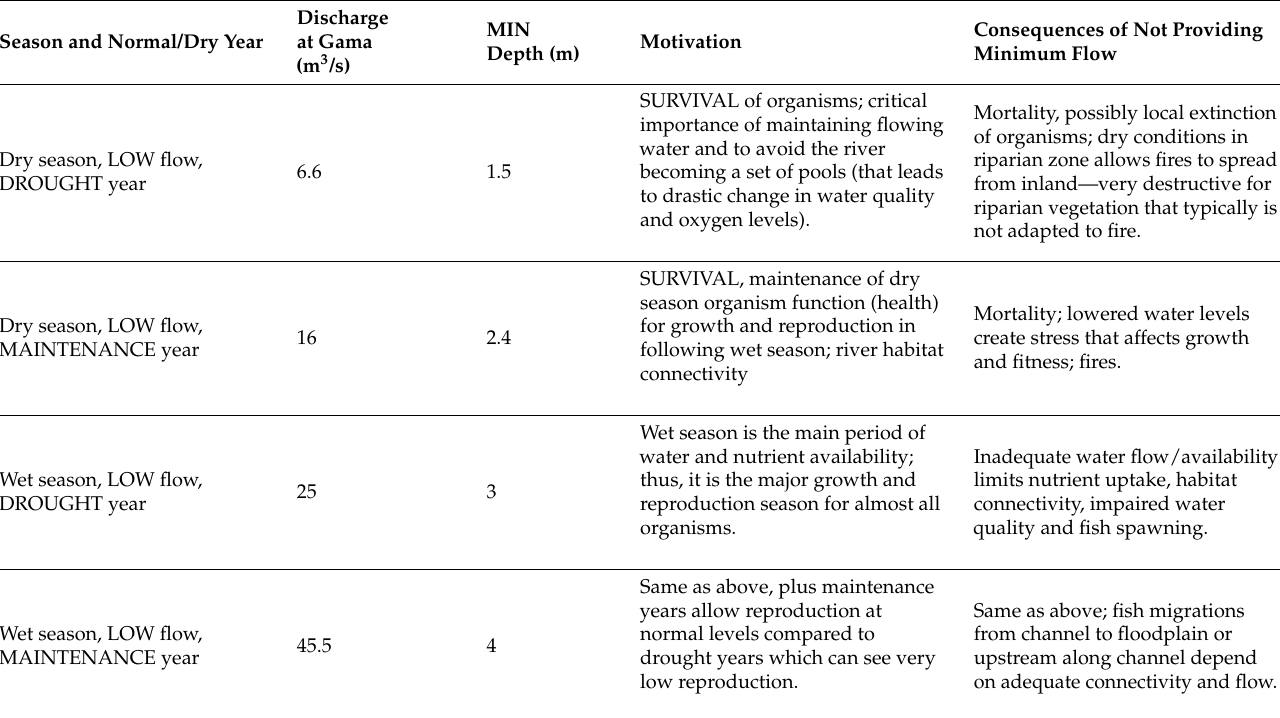
Table 6. Summary of minimum discharges and corresponding minimum water depths necessary at Gama Gate for the 6 different hydrological conditions to avoid ecosystem